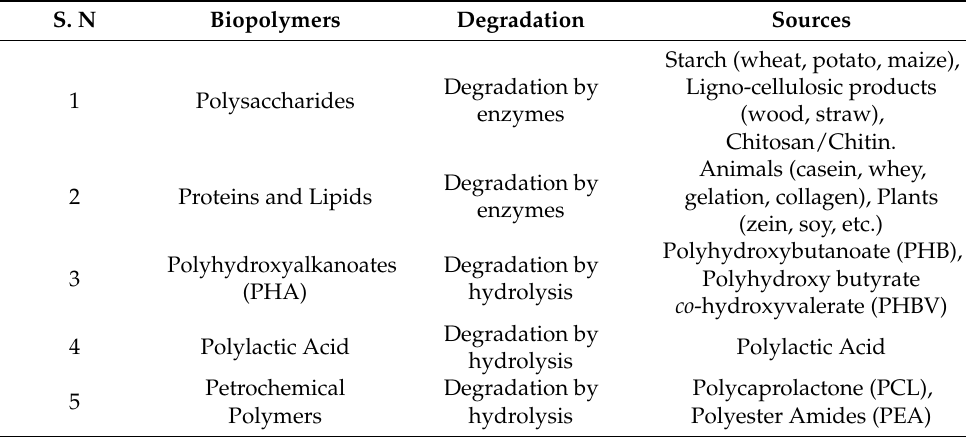
Table 1. Biopolymers and biopolymer degradation